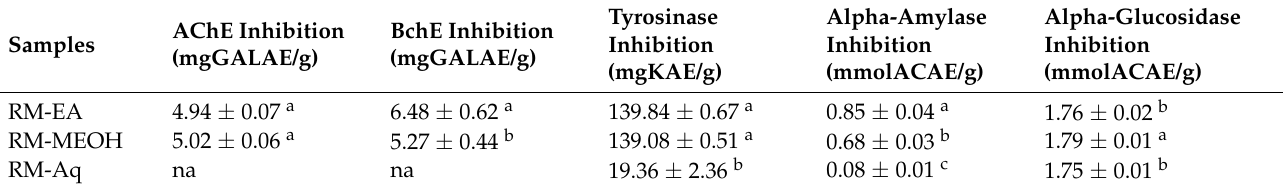
Table 4. Enzyme inhibitory